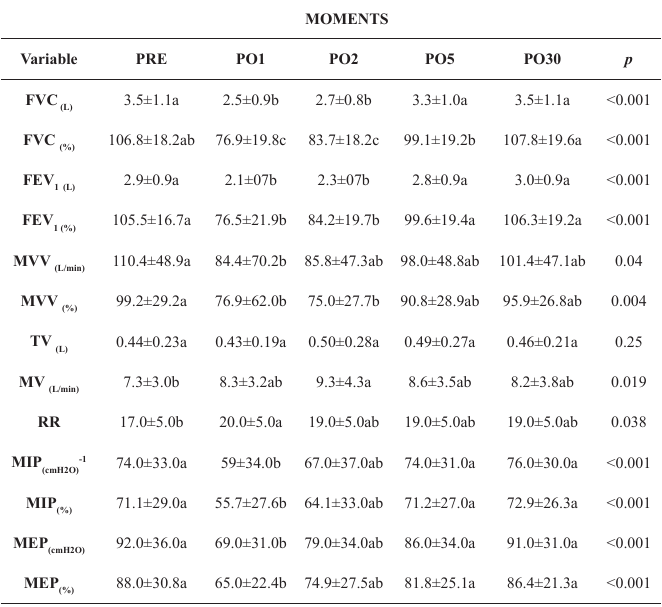
TABLE 1 – Mean and standard deviation for the spirometry, ventilometry and manovacuometry variables and p